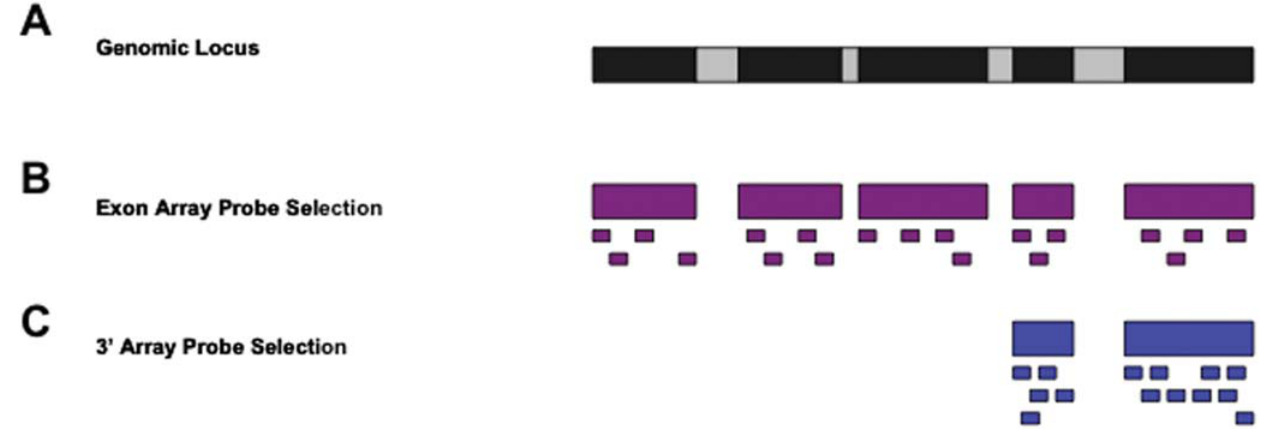
Figure 1. Probe design of exon arrays. ( A ) Exon-intron structure of a gene. Black boxes represent exons. Gray boxes represent introns. Introns are not drawn to scale. ( B ) Probe design of exon arrays. Exon arrays have four probes targeting each exon of the gene. ( C ) Probe design of 3 9 expression arrays. Probes on 3 9 expression arrays target 3 9 end of the mRNA sequence.